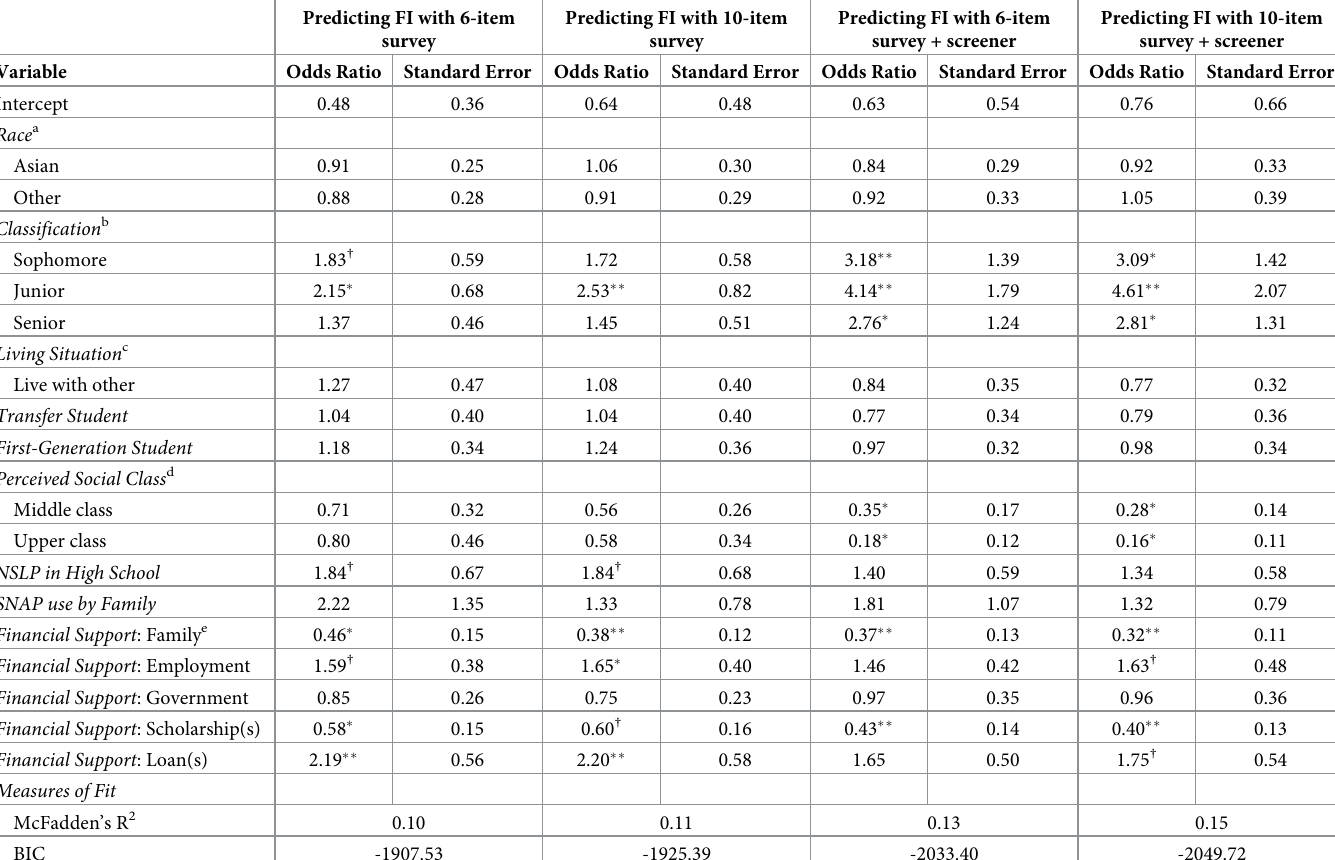
Table 5. Comparison of assessment protocols predicting food insecurity (FI) among undergraduate college students based on theoretical predictors in logistic regression models (n = 427).